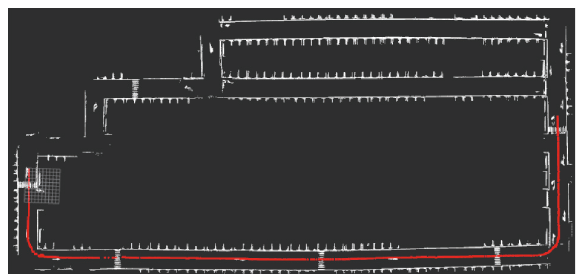
Figure 15: Experimental localization result in the parking lot.